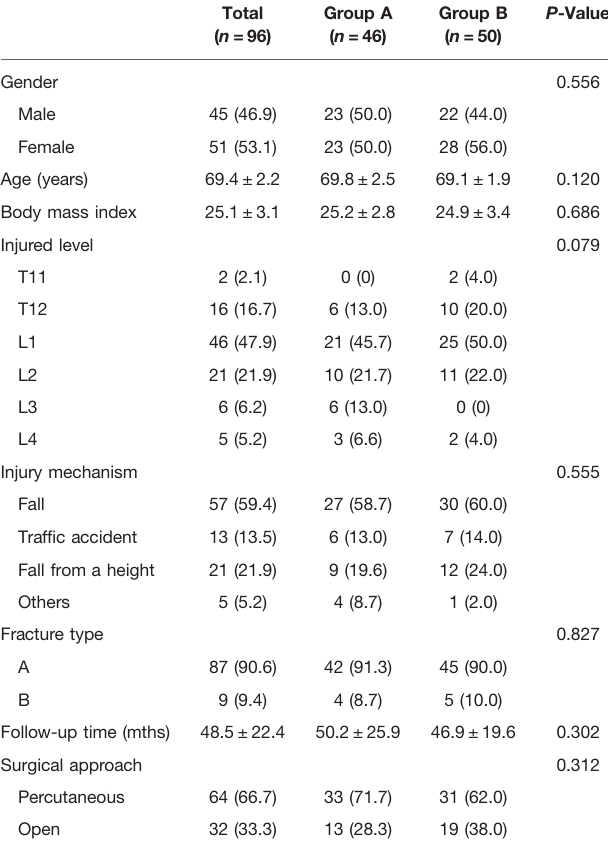
TABLE 1 | Patient characteristics at the time of